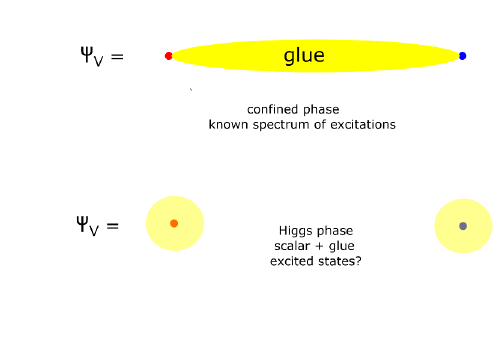
Figure 1. In a confining gauge theory, the color flux tube em- anating from static charged sources has a discrete spectrum of fluctuations. We suggest that the same may be true of the gauge and scalar fields surrounding charged sources in the Higgs phase of a gauge Higgs